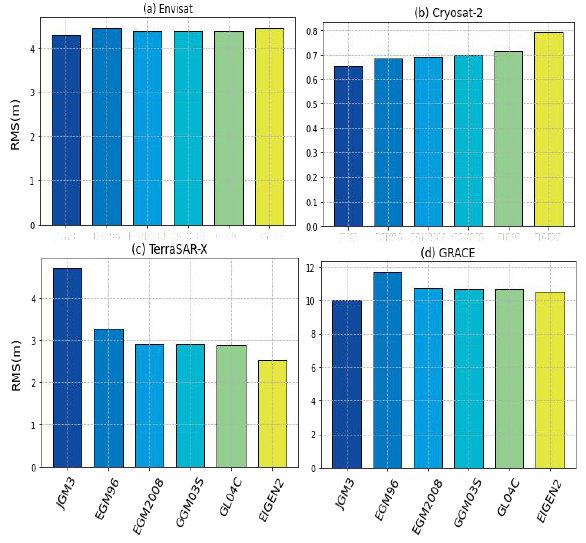
Figure 3. Comparison of 3-days different satellite orbits prediction precision with the different gravity